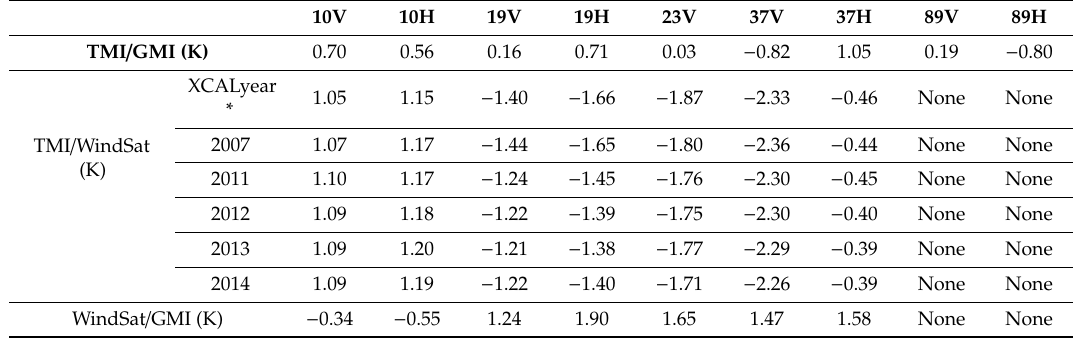
Table 7. Average calibration biases for intercalibration of MI / GMI, TMI / WindSat, and WindSa / GMI.